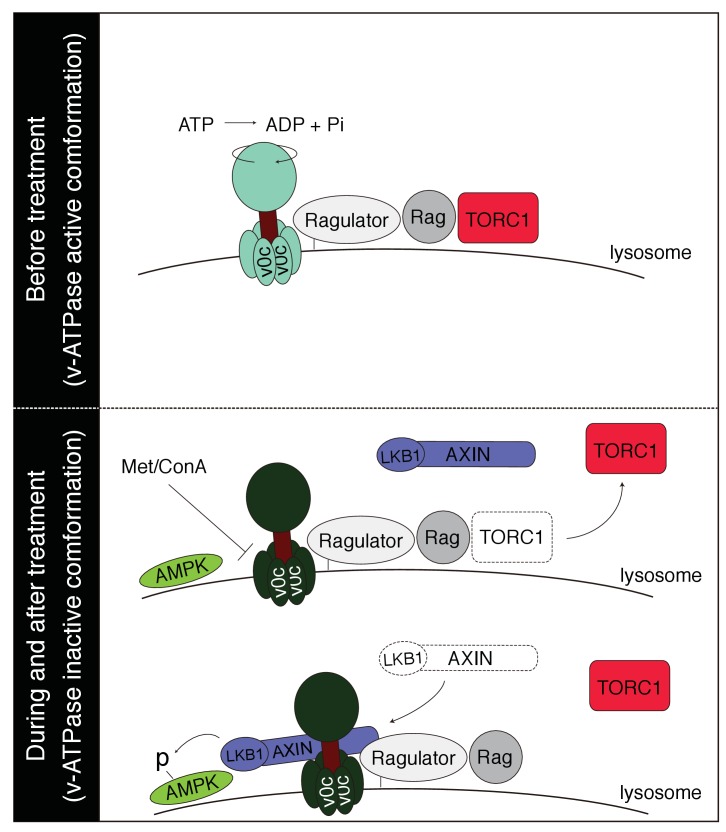
Proposed model for metformin’s action.Under normal condition, v-ATPase is in an active conformation, which mediates lysosomal amino acid signaling to recruit and activate TORC1. Metformin treatment may target v-ATPase and change its conformation, leading to the dissociation and inactivation of TORC1. Meanwhile, v-ATPase-Regulator may act as a platform for the docking of AXIN/LKB1 and subsequent activation of AMPK.